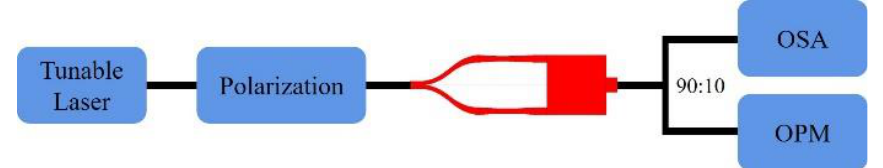
Figure 8. Schematic diagram of E 00 -E 10 mode converter measurement setup.